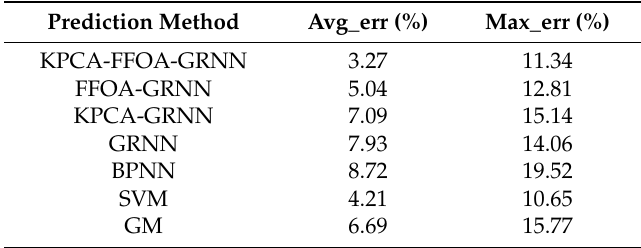
Table 2. Prediction error for different prediction method (%).